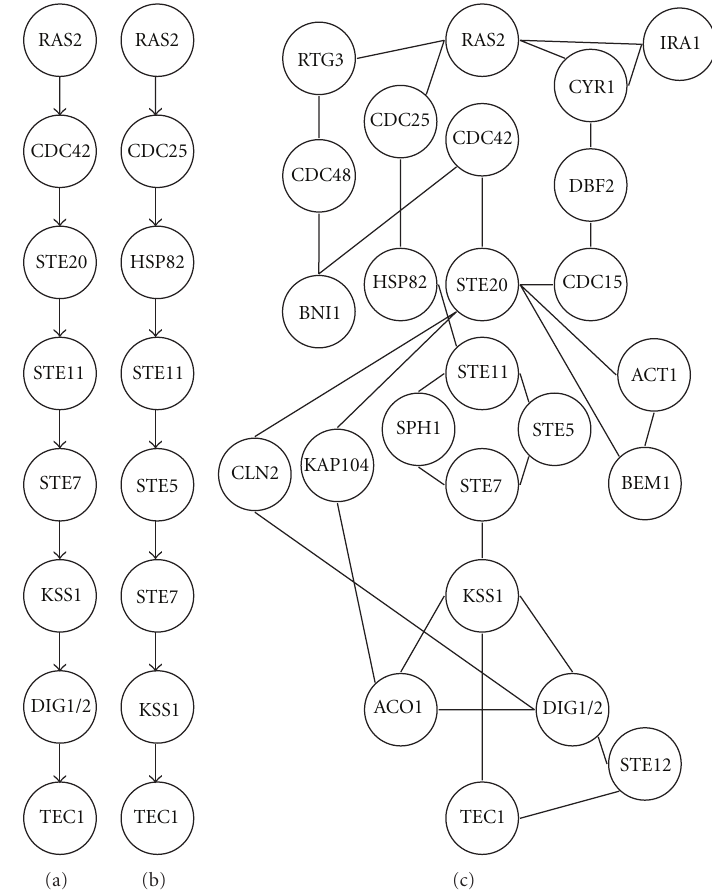
Figure 6: (a) The main chain path of filamentous growth pathway (b) the main chain detected by Scott et al. method (c) the assembly paths detected by our